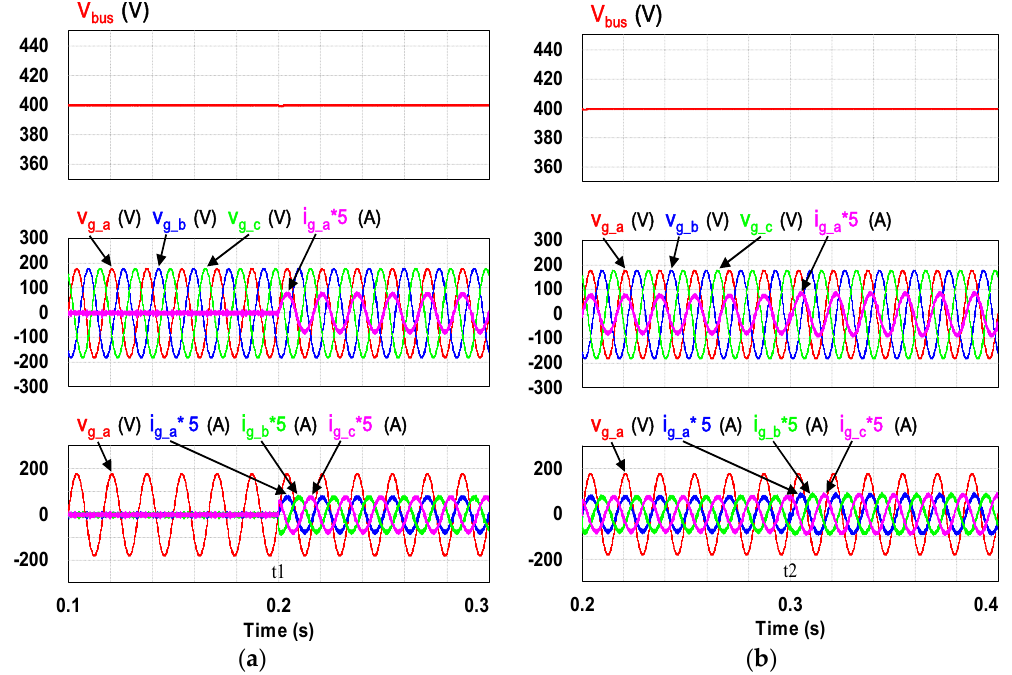
Figure 25. The detailed view of Figure 23: ( a ) near t1; ( b ) near t2.